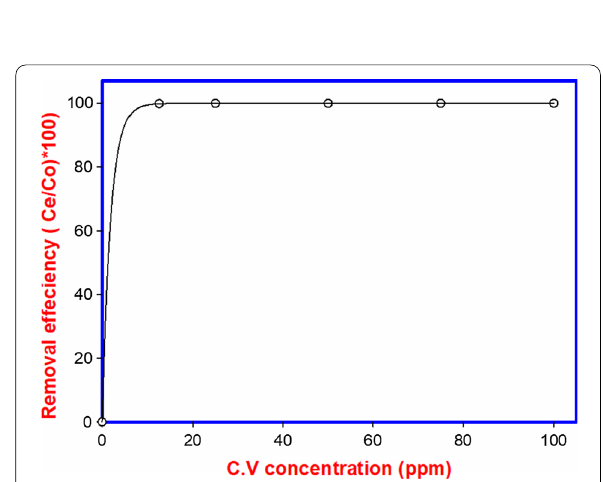
Fig. 9 Effect of dye concentration on the removal efficiency of C.V over sodium titanate